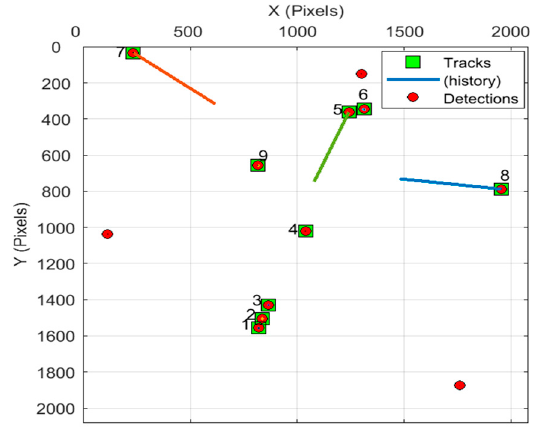
Figure 14. Seq_III detection result.